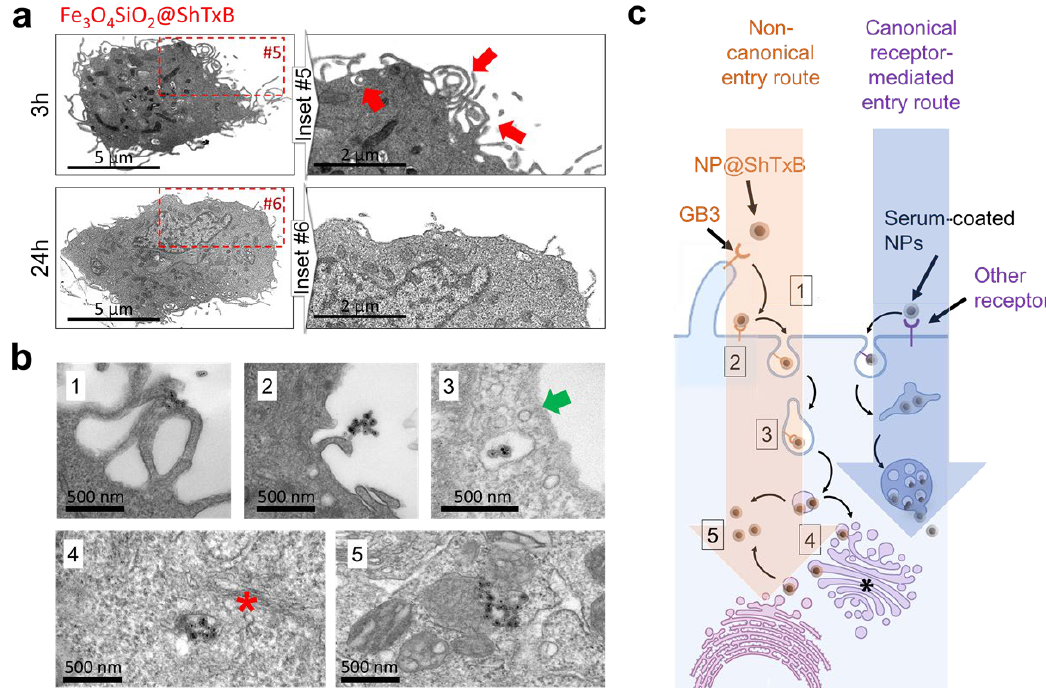
Figure 4. Biomimetic retrotranslocation of the ShTxB-coated NPs. ( a ) TEM images of sections of human HNC cells exposed to ShTxB-coated nanoparticles for 3 h (top) or 24 h (bottom). (inset #5) Functionalized nanomaterials unchain a huge membrane activity upon cell contact (red arrows). This membrane activity is transitory, being restored upon particle cytoplasmic invasion (inset #6). A control cell can be seen in Figure S5. ( b ) Localization of the ShTxB-coated nanoparticles by TEM. The following numbers correspond to those in the diagram in ( c ). (#1) The nanomaterials are being contacted by filopodia. (#2) Filopodia retraction and nanoparticle transport towards the cell surface. (#3) Nanoparticle engulfment in large irregular membranous structures different from conventional endocytic vesicles (green arrow). (#4) Nanoparticle association to membranes resembling the endoplasmic reticulum and Golgi apparatus (asterisk). (#5) Nanoparticles in the cytosol devoid of membranes, intermingling with the cellular organelles. ( c ) Diagram of the proposed non-canonical cell entry route observed for ShTxB-coated nanomaterials. The ‘non-canonical’ route is triggered by the interaction of the ShTxB-coated nanoparticles with the GB3 receptors. This unchains exacerbated membrane activity, leading to nanomaterial retrotranslocation via endoplasmic reticulum to Golgi apparatus (asterisk). Boxed numbers correspond to the stages indicated in Figure